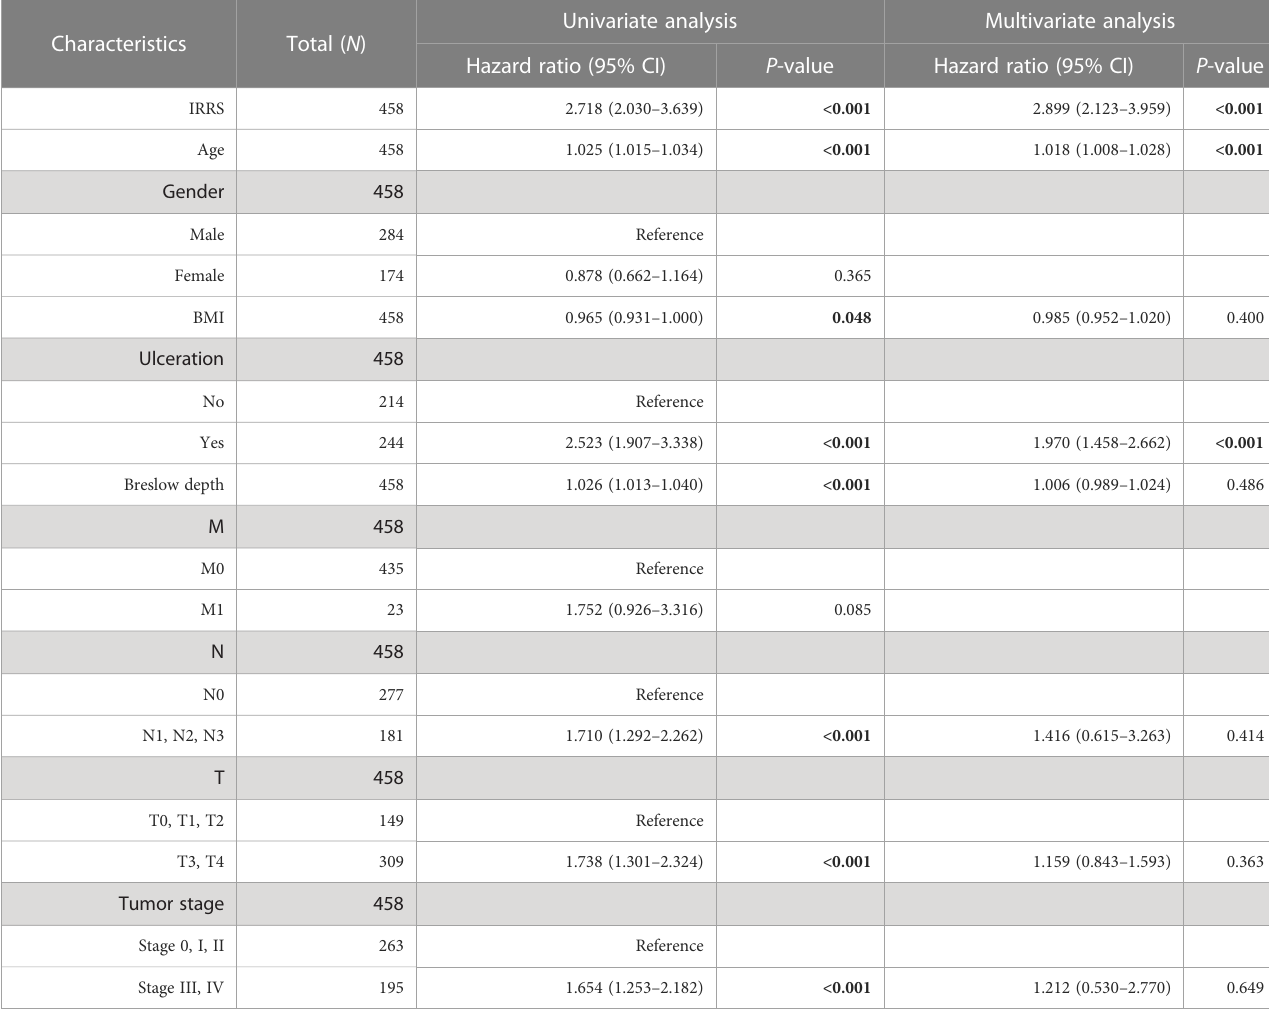
TABLE 2 Univariable and multivariable Cox regression analyses of the IRRS and survival in the TCGA cohort.